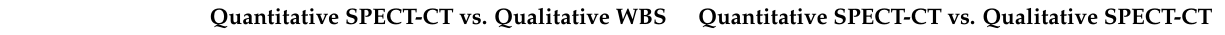
Table 4. Correlation coefficient and statistical significance between qualitative and quantitative imaging interpretation methods.